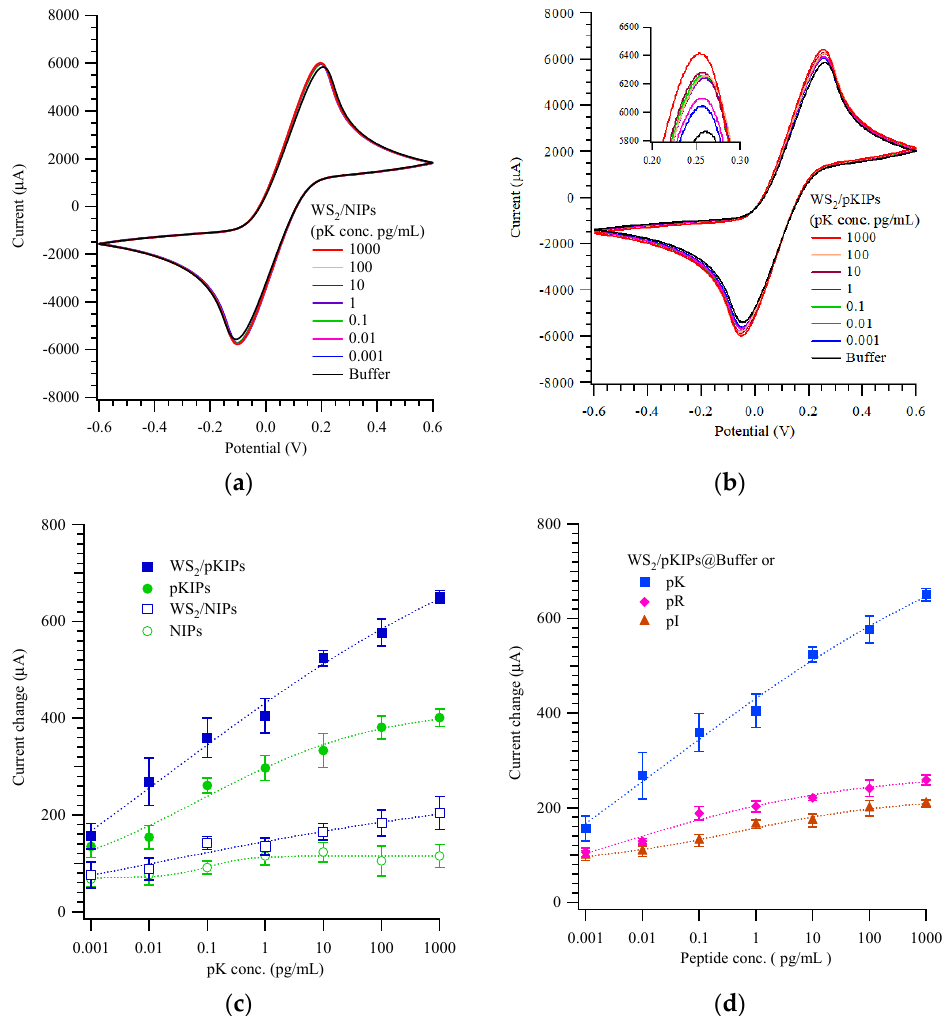
Figure 2. Cyclic voltammograms of various peptide K concentrations using ( a ) WS 2 -doped NIPs- and ( b ) WS 2 -doped pKIPs-coated electrodes. ( c ) Peak oxidation currents (at 0.19~0.21 V), relative to that obtained with buffer, when electrodes were immersed in solutions containing target peptide pK at concentrations varying over seven orders of magnitude, using the electrodes shown in ( a , b ). ( d ) Interference of CRP pR and pI peptides on the WS 2 -doped pKIPs-coated